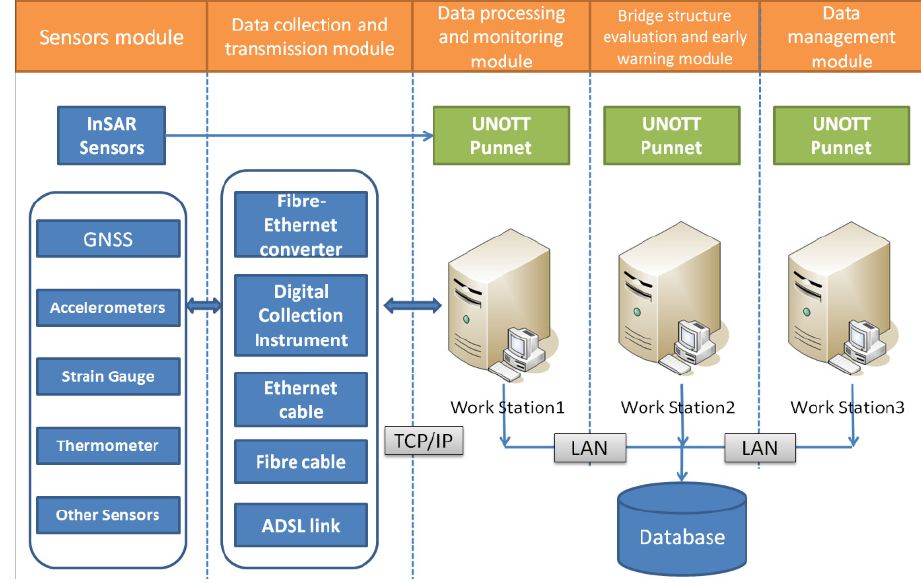
Figure 3. The relationship of GeoSHM sub ‐ systems and data flow.